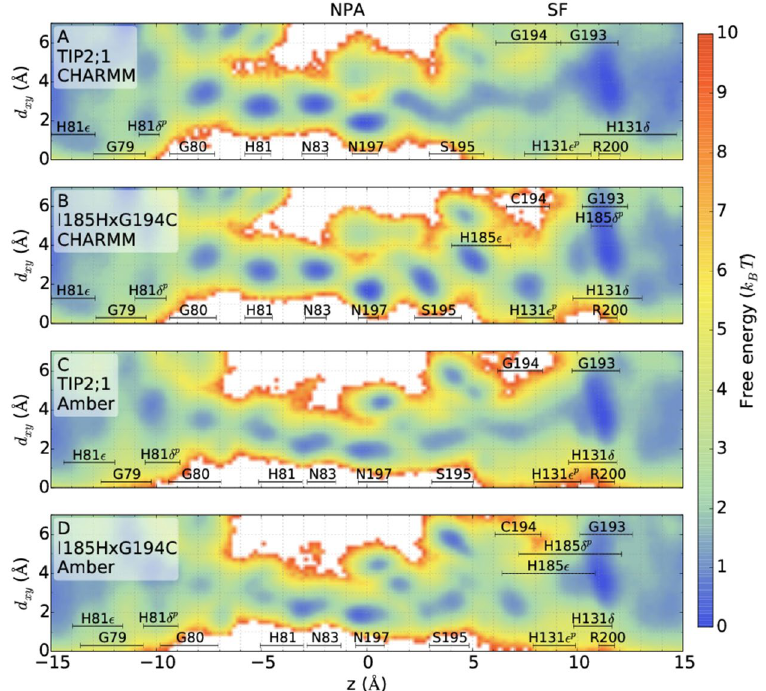
Figure 2. Free energy of water positions as a function of the distance along z and the radial distance from the channel center of mass, d xy . The free energies were calculated from water densities in unbiased simulations. Average z positions ( ± the standard deviation) of water molecules when hydrogen bonding to pore sites are indicated. The positions of the labels along the y -axis are arbitrary (do not indicate d xy position). For the histidines, both N δ and N  sites are included separately. The protonated nitrogen is indicated by superscript p . See Supplementary Fig. S1 for the free energies of the single